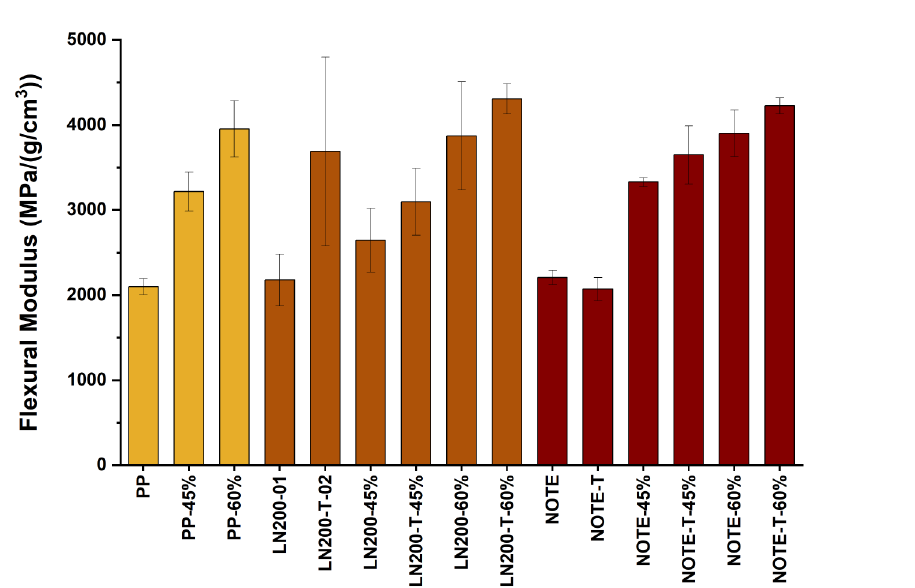
Figure 8: Flexural specific properties.